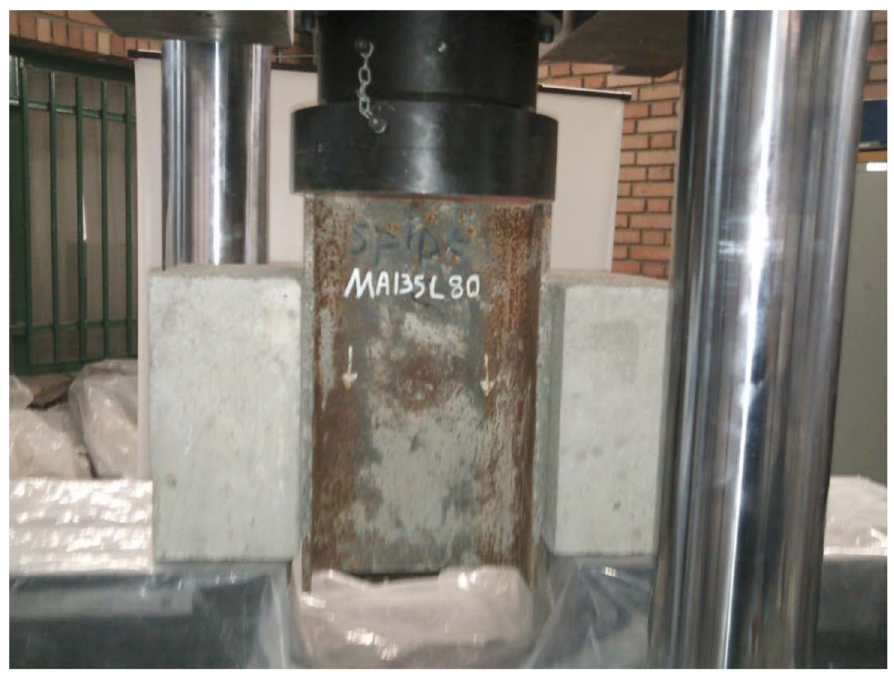
Fig 4. Test setup for MA135L80.